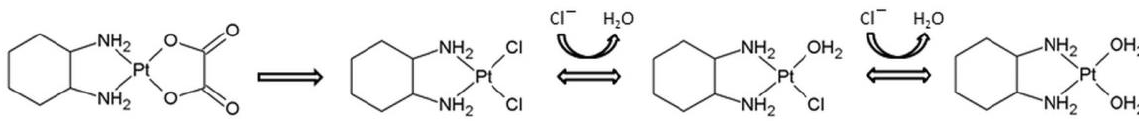
Figure 3. Biotransformation pathway of Oxaliplatin.